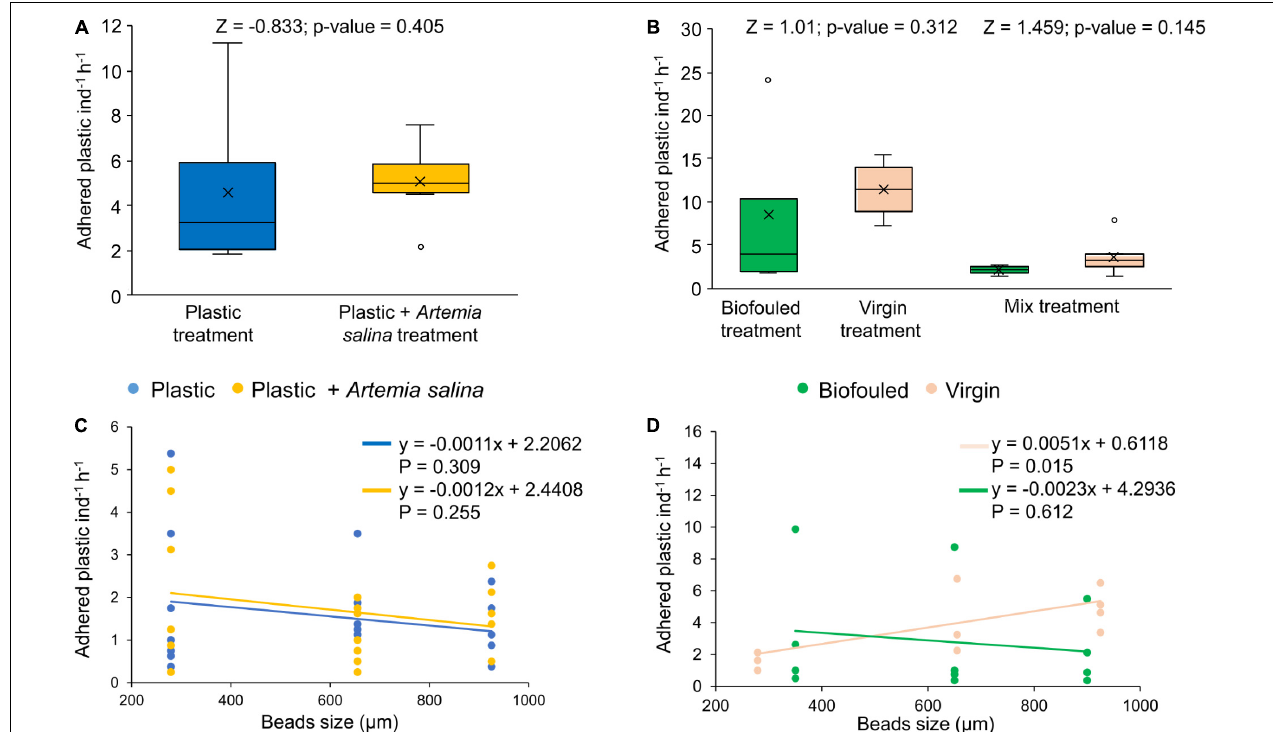
FIGURE 3 | Plastic removal by adhesion and distribution of adhered plastic in size classes. (A) Adhered plastic (number of microplastic beads individual - 1 hour - 1 ) in corals exposed to two treatments: corals treated with plastic (“Plastic,” in blue, N = 7) and treated with plastic mixed with Artemia salina (“Plastic + Artemia salina ,” in yellow, N = 7). (B) Adhered plastic (number of microplastics individual - 1 hour - 1 ) in corals exposed to three treatments: corals treated with biofouled plastic only (“Biofouled,” in green, N = 4), with virgin plastic only (“Virgin,” in pink, N = 4) and biofouled plastic (in green), and virgin plastic (in pink) mixed (“Mixed,” N = 6). All estimates have been compared with Wilcoxon tests for which the p -value and Z value are reported in the figures. (C) Distribution of adhered plastic in size classes in the Plastic treatment (blue) and in the Plastic + A. salina treatment (yellow). (D) Distribution of adhered plastic in size classes in the Virgin treatment (pink) and in the Biofouled treatment (green). In plots (C,D) , size classes are reported as the mean value of the size class bin. Lines represent the linear fit of each set of data of the corresponding color. Equations and p -values of each linear model are reported in